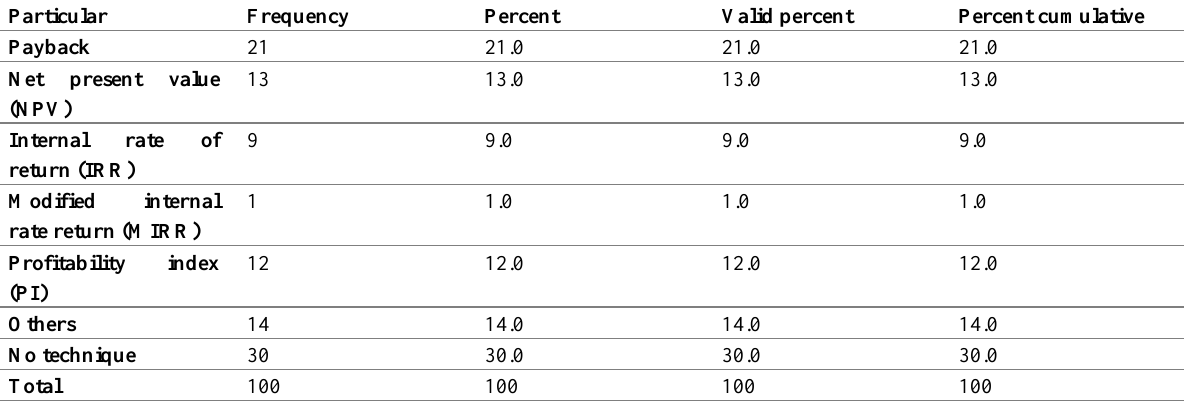
Table 6: Evaluation